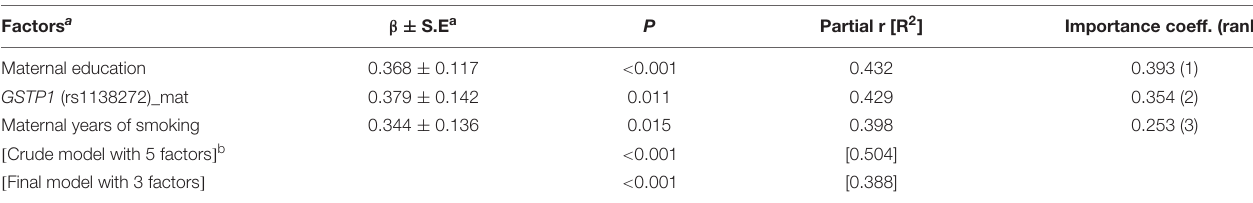
TABLE 7 | Factors associated with placental transfer rate of Pb (CATREG